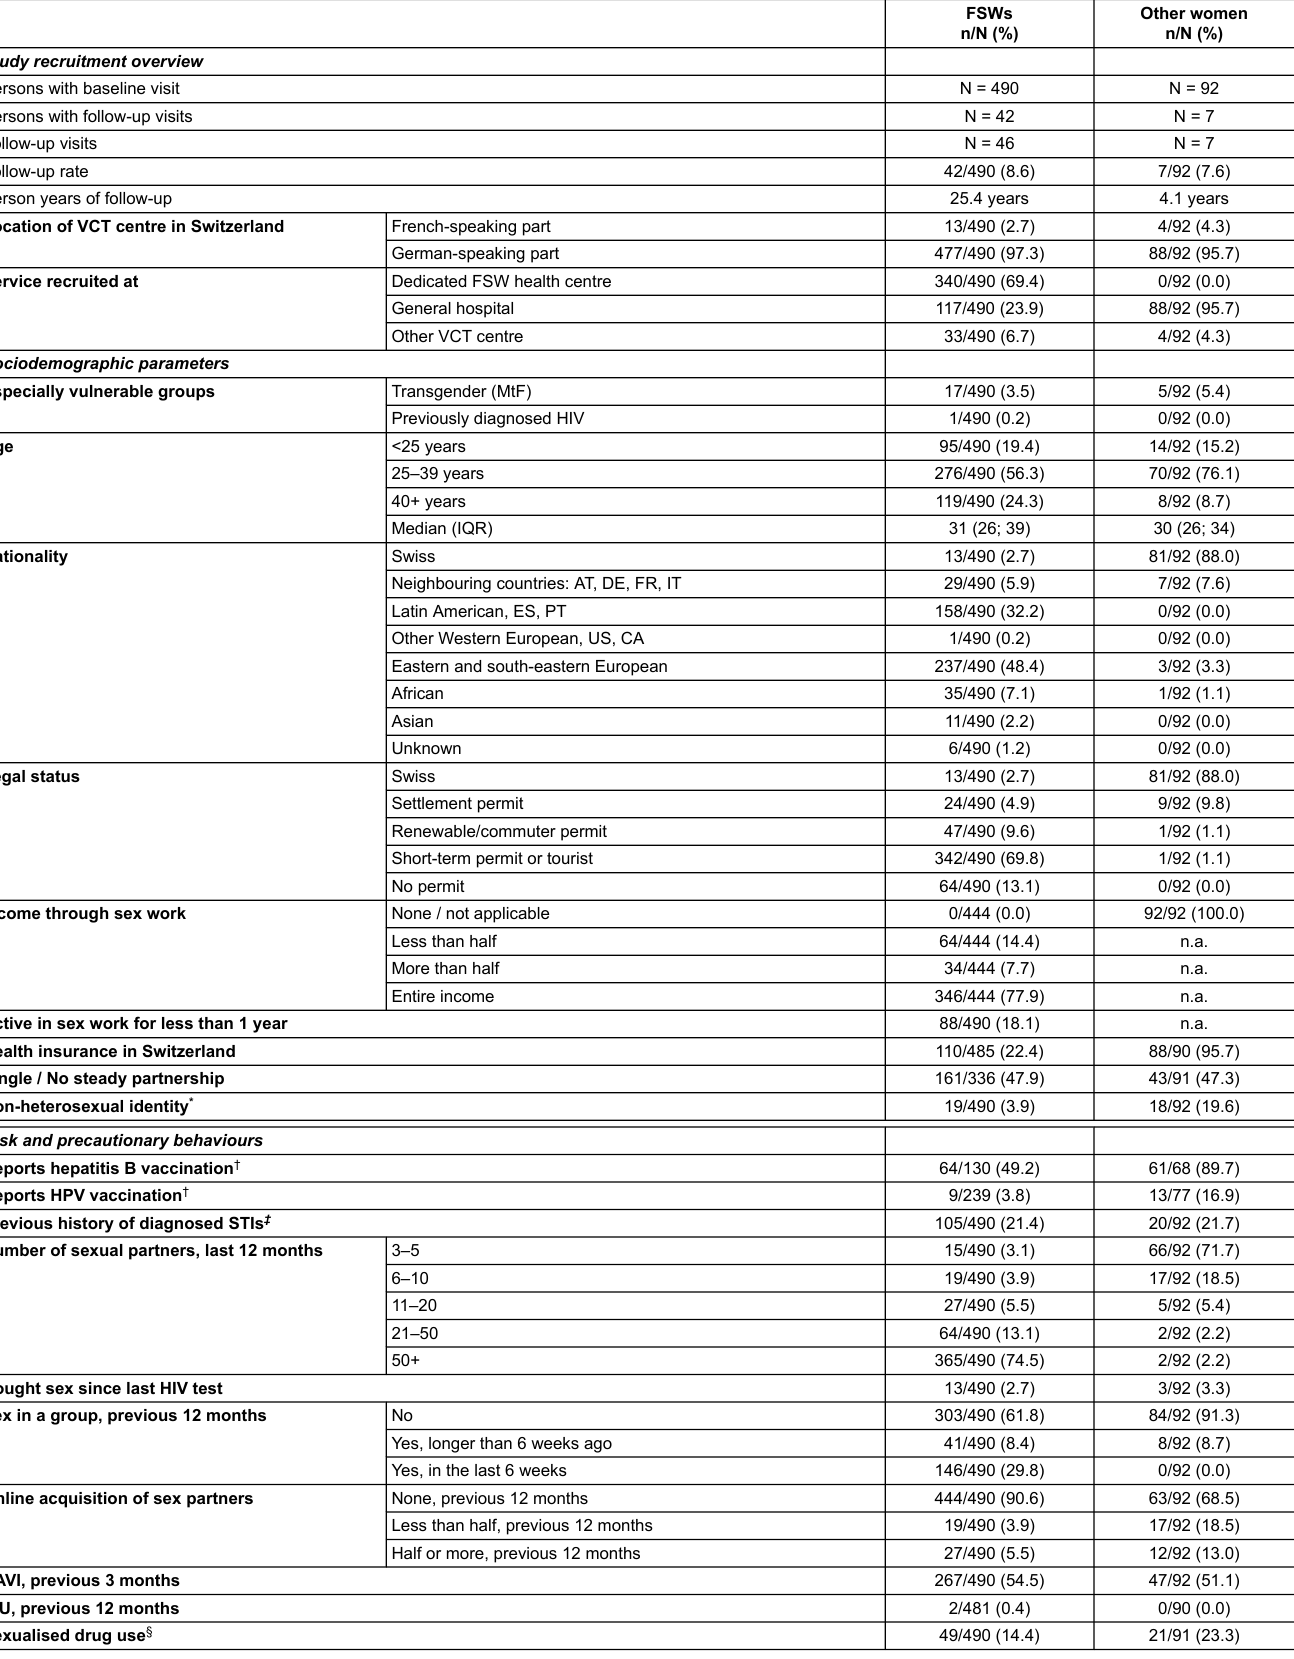
Table 1: Overview and sociodemographic parameters, risk and precautionary behaviours at baseline.